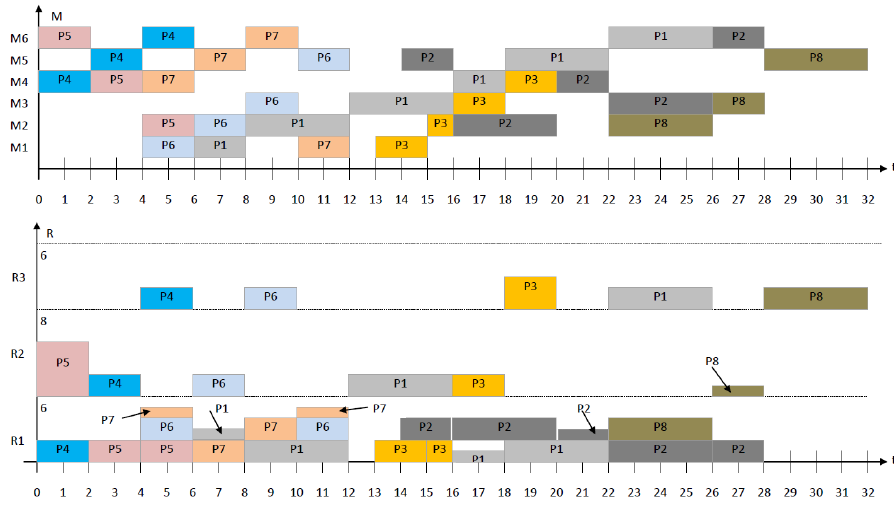
Fig. 6. Gantt charts which visualize the answer to the question Q 10 (upper one: the allocation of machines and lower one: the use of additional resources).